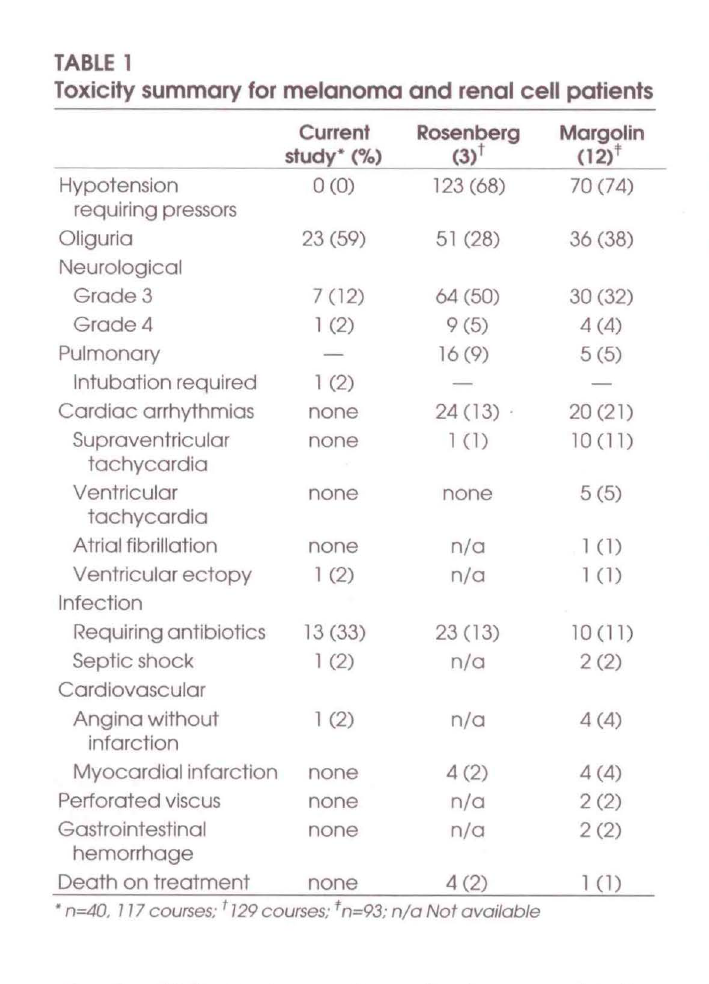
Toxicity summary for melanoma and renal cell patients